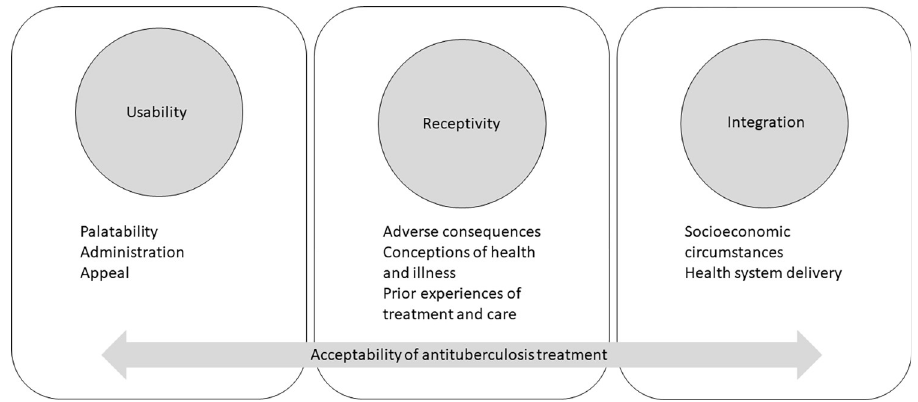
Fig 1. Diagrammatic depiction of conceptual framework for determining overall TB treatment